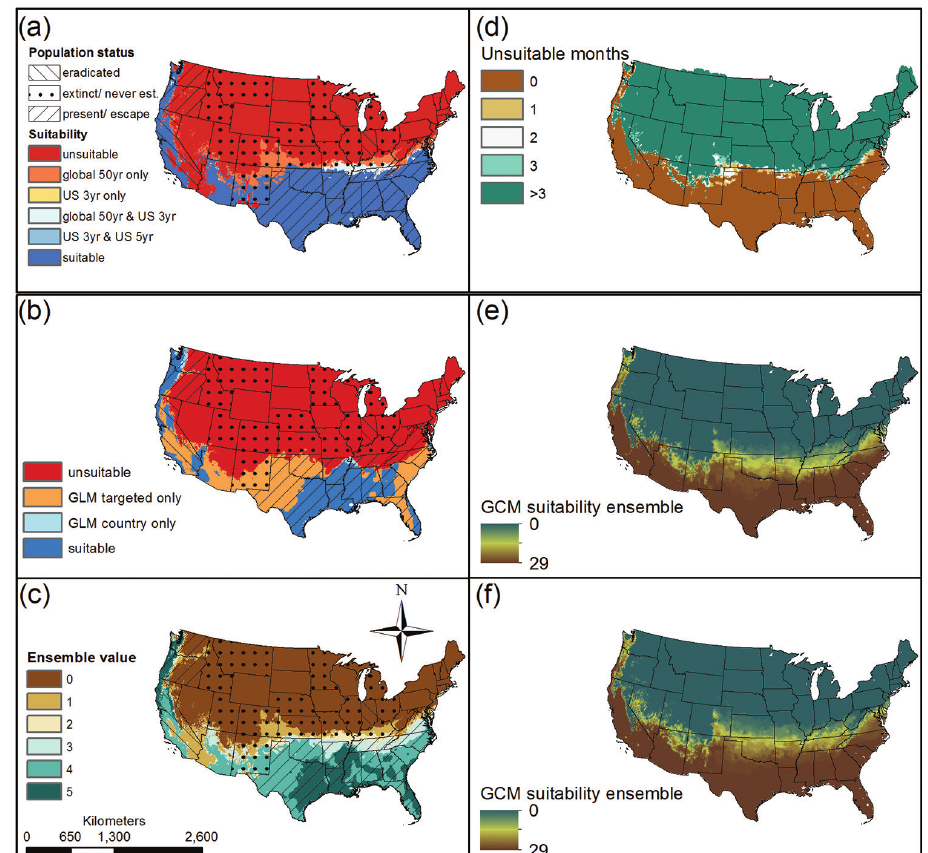
Figure 2. Model predictions for Myocastor coypus [Molina, 1782] for a an ensemble of US 3yr, US 5yr, and global 50yr b an ensemble of GLM country and GLM targeted c an ensemble of all five models d number of months classified as unsuitable using the Maurer observed climate data for 2001 to 2010 e the number of GCMs defining each pixel as suitable (ensemble of the 29 binary downscaled GCMs using the Maurer dataset as the reference) f ensemble of the 31 downscaled GCMs average from 2040 to 2050. All maps are overlaid with USA state population status according to Carter and Leonard (2002). Unsuitable habitat is defined as areas where no models predicted the area as suitable, while suitable areas are defined according to which model(s) predicted suitable habitat. Maps are in Albers Equal Area